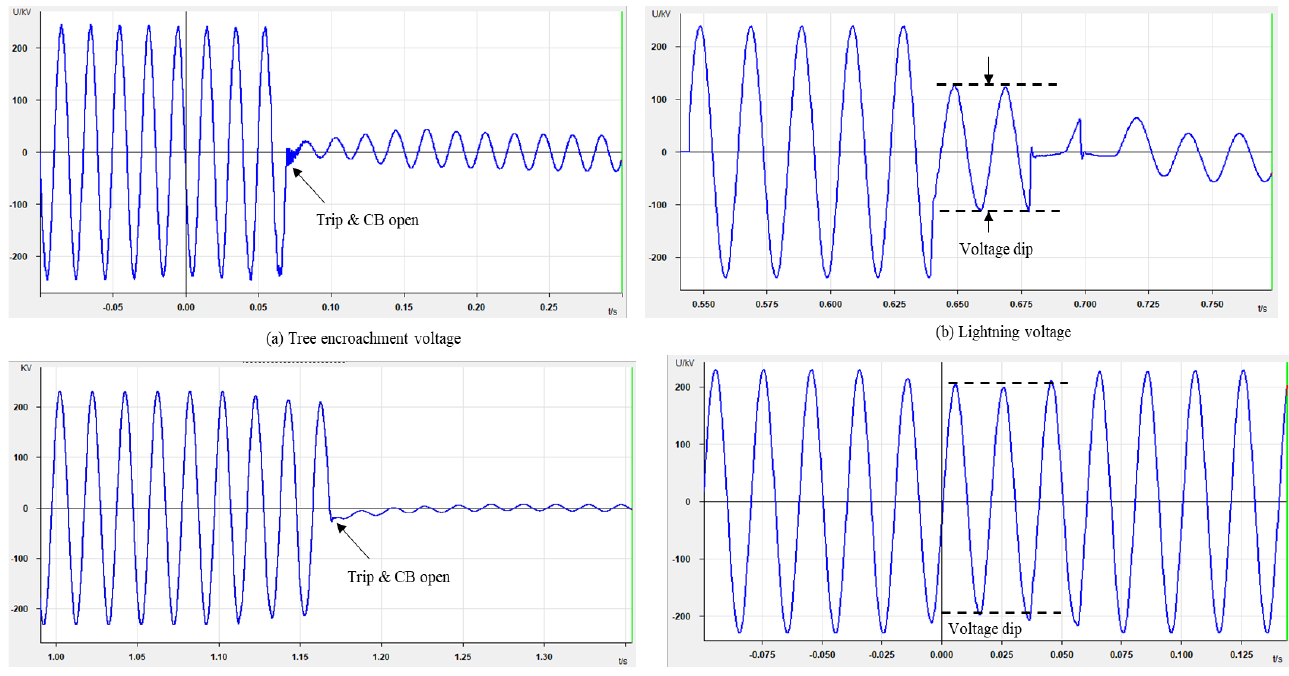
Figure 15. Fault signature for voltage phase sinusoidal waveform.